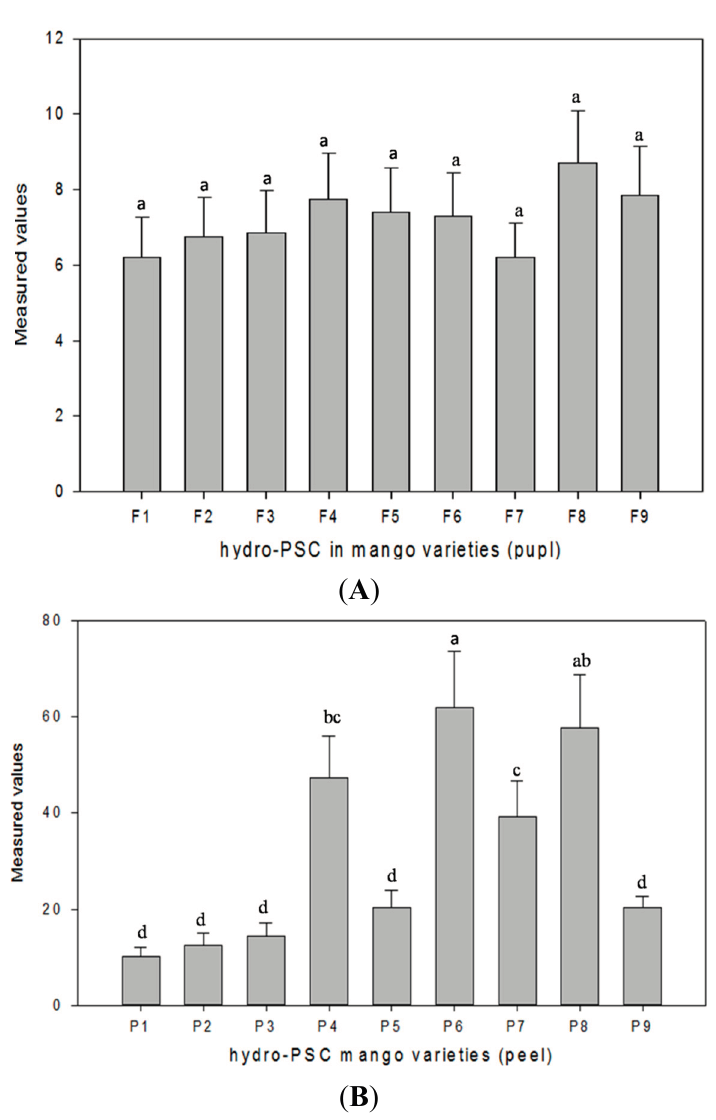
Figure 2. ( A ) Hydro-PSC values ( μ M vitamin C equivalent/g FW) in pulp samples; the means of three replicates ± SD; letters “a” indicate significant difference at p < 0.05; ( B ) Hydro-PSC values ( μ M vitamin C equivalent/g FW) in peel samples, the means of three replicates ± SD; different letters “a–d” indicate significant difference at p <